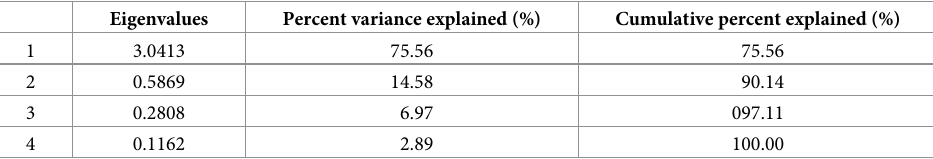
Table 5. Results of the second step